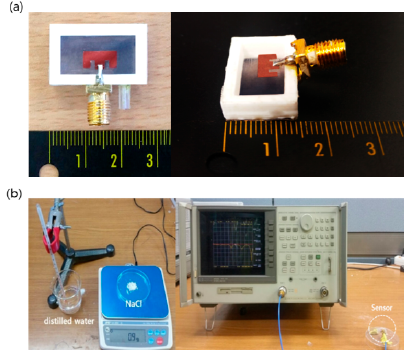
Figure 4. ( a ) Fabricated sensor; ( b ) Experiment setup.